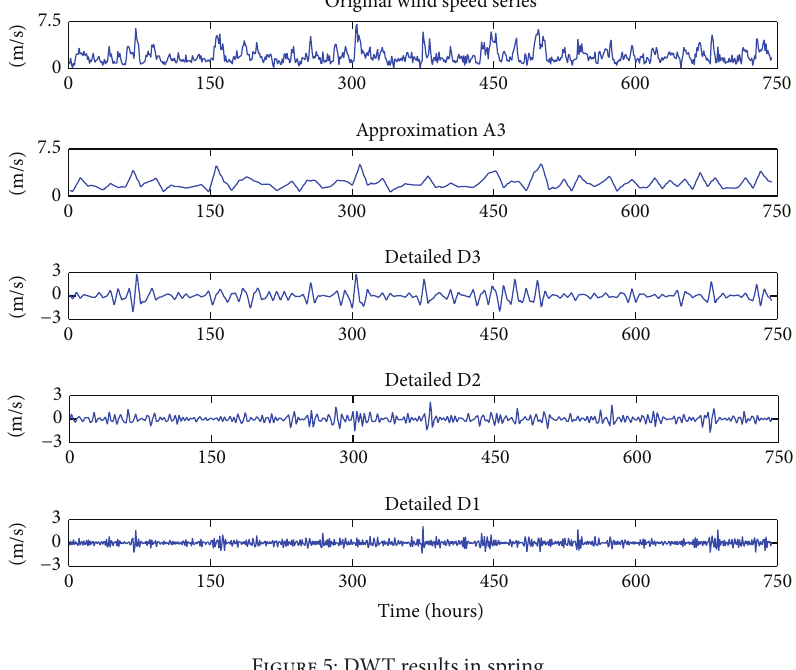
is made by using the 1–600th series of all the original wind speed series and subseries. To estimate the performance of each run of the experimental simulation, the MSE is used. Each simulation is run at least 30 times to obtain the mean values. The results of the experimental simulation in spring are shown in Table 3. Similarly, the results of the experimental simulation in other seasons can be got. The optimal